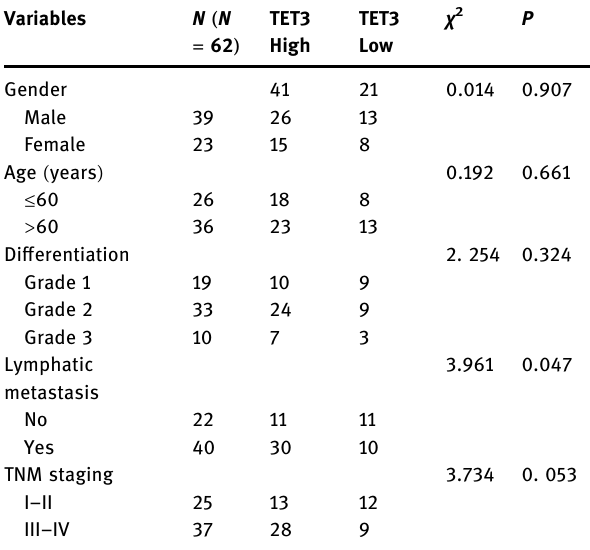
Table 1: Correlation between TET3 expression and ESCC clinico